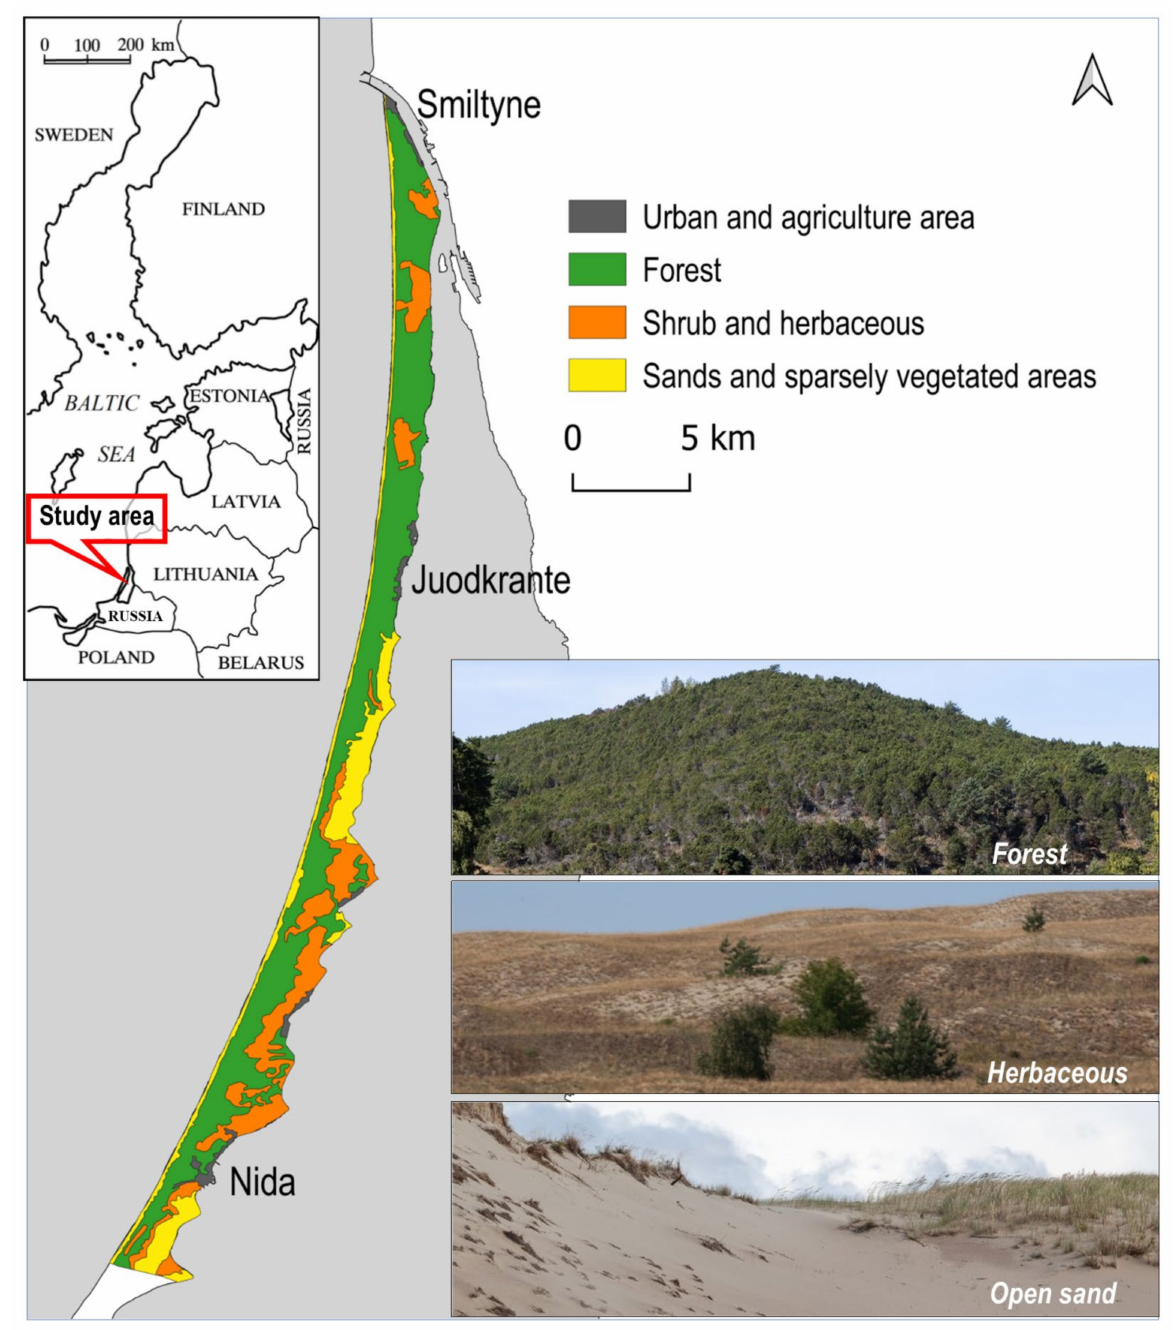
Figure 1. The location of the Curonian Spit and its three ecosystem types: forest, herbaceous, and